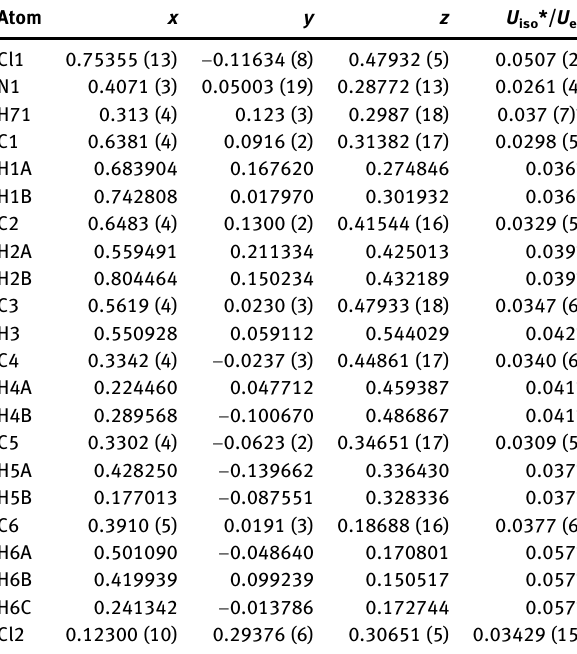
Table  : Fractional atomic coordinates and isotropic or equivalent isotropic displacement parameters (Å 